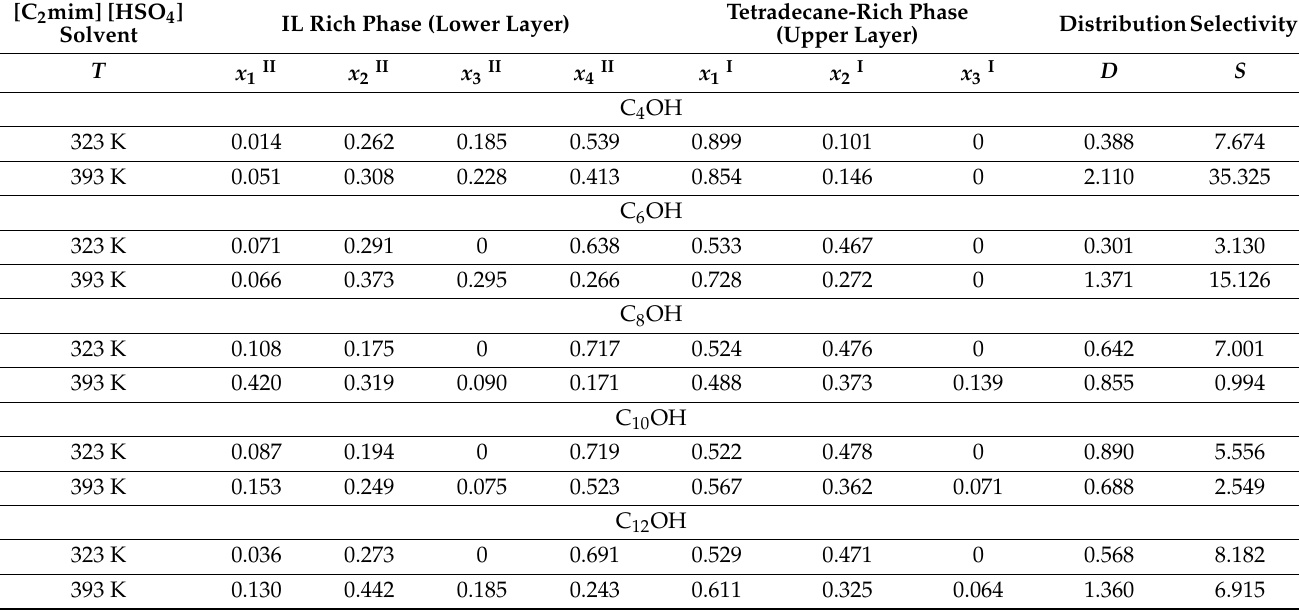
Table 3. Selectivity and distribution ratios for 1-alcohol/ n -tetradecane mixtures contacted with 1-ethyl-3-methylimidazolium hydrogensulfate at 323 and 393 K and at 101 kPa a